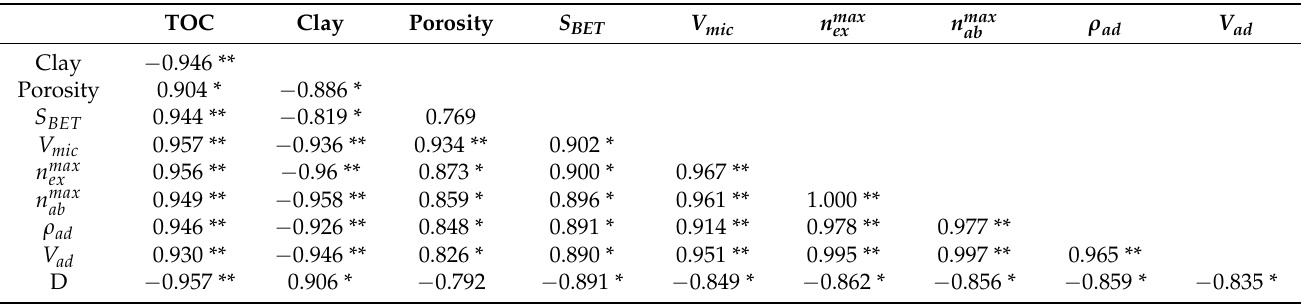
Figure 4. Plots showing the relationships between the maximum excess adsorption with the TOC content ( a ) and the maximum absolute adsorption with the TOC content ( b ). (The adsorption temperature is 60 °C and the Longmaxi and Niutitang shales are from Pan et al. [8] and Li et al. [14], respectively). Table 3. Pearson correlation analysis between adsorption parameters and reservoir physical properties of the studied samples.